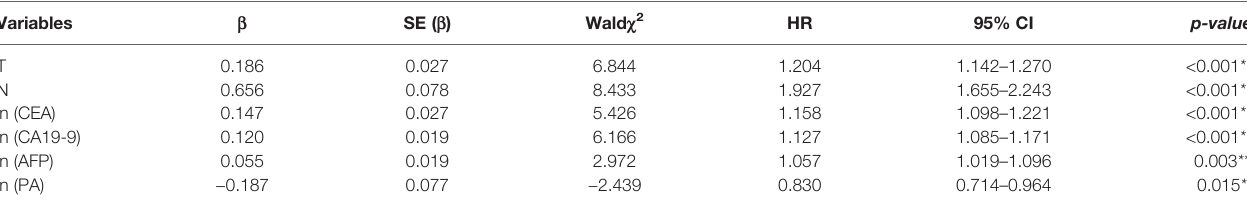
TABLE 4 | Multivariate regression analysis in the training cohort (n=1,112).